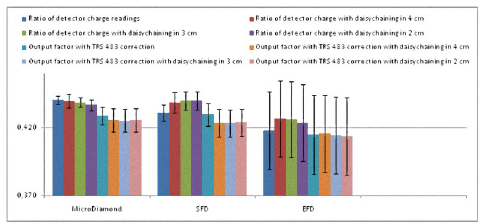
Fig 4. Ratio of detector readings and OFs for the 1 × 1 cm 2 field for the 6 MV beams with different detectors. Results for daisy chaining in 4 x 4 cm 2 , 3 x 3 cm 2 , and 2 x 2 cm 2 are included.